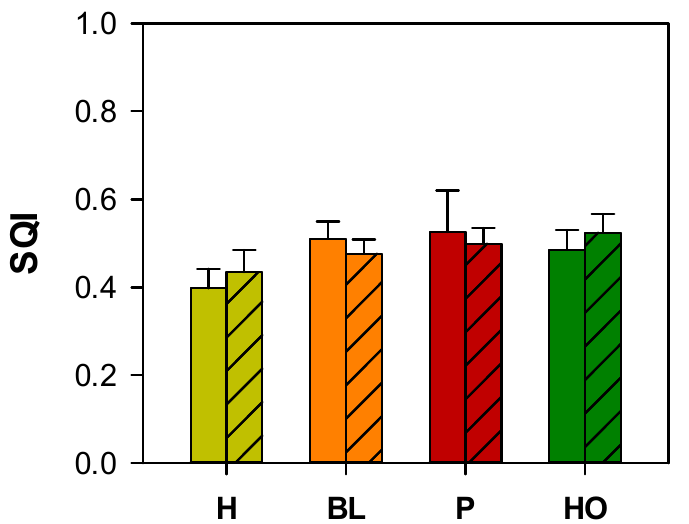
Figure 1. Mean values ( ± st. err.) of soil quality index (SQI) calculated in unburnt (no pattern) and burnt (coarse pattern) soil samples collected under different vegetation cover types (herbs—H, light green; black locust—BL, orange; pine—P, red; holm oak—HO, dark green). No significant differences among vegetation cover types and between burnt and unburnt soils were detected (Kruskal–Wallis test).